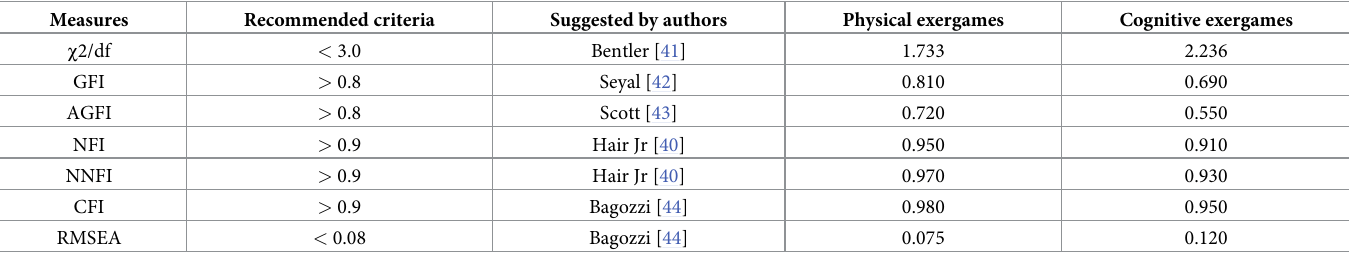
Table 7. Fit indexes for the measurement model of both types of